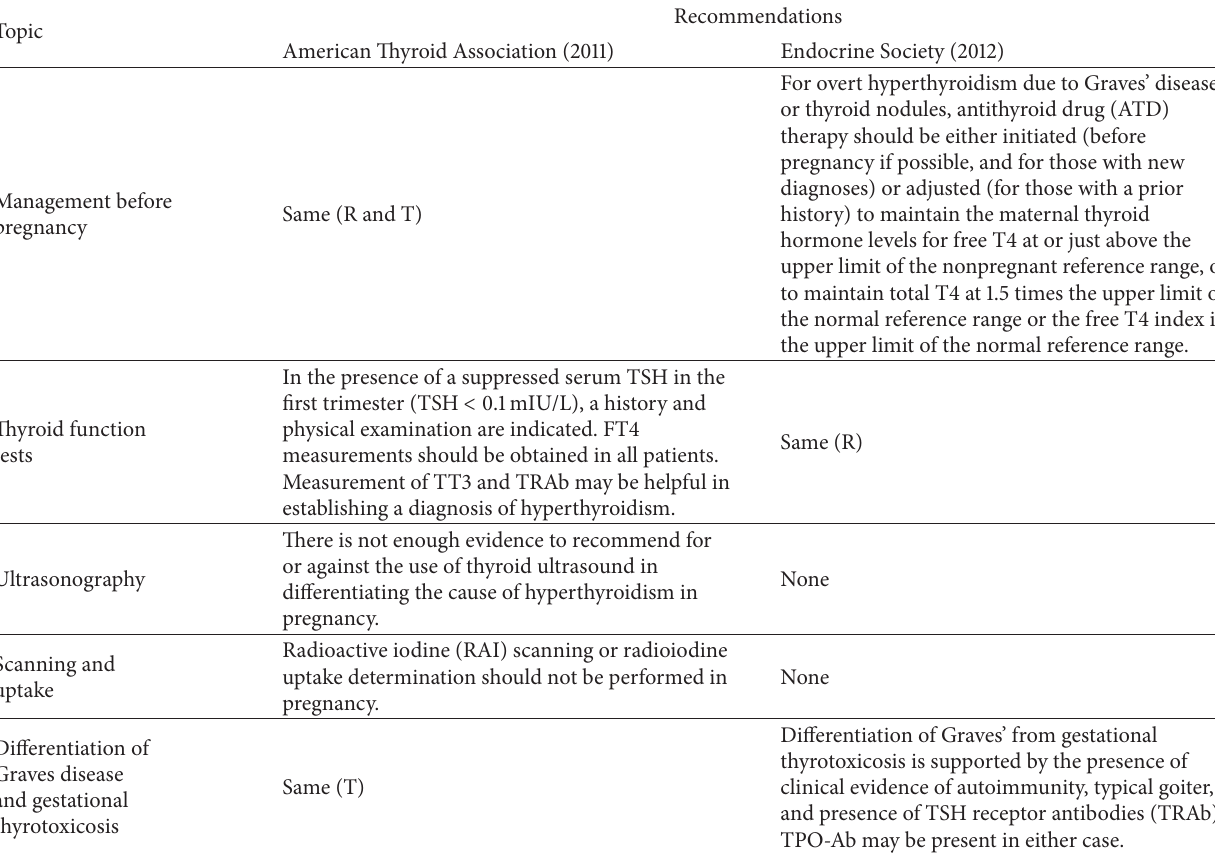
Table 1: Comparison of recommendations of American Thyroid Association and Endocrine Society on the management of hyperthyroidism before pregnancy and on the diagnosis of hyperthyroidism and